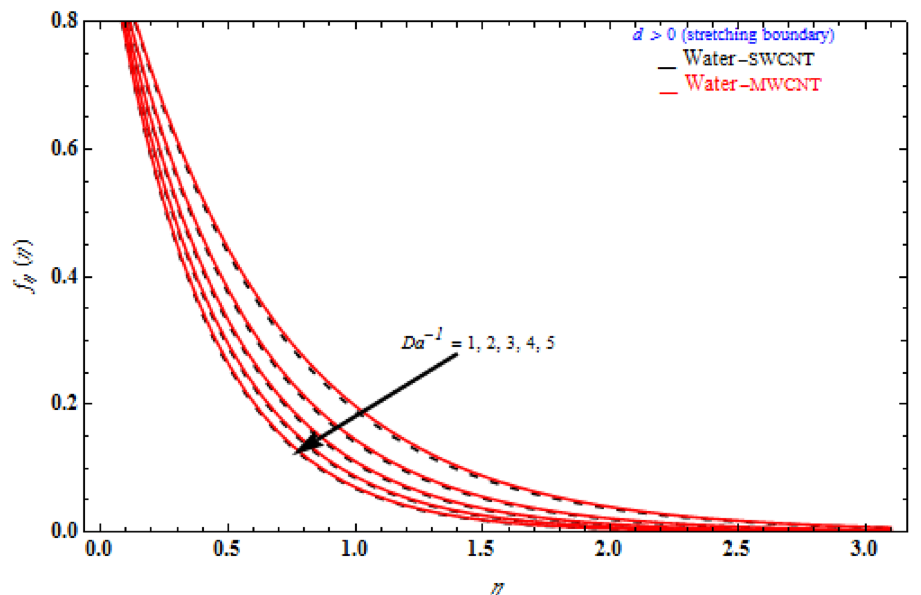
Figure 7. Influence of Da -1 on axial velocity with k 1 = 1, M = 1, τ = 90° for stretching